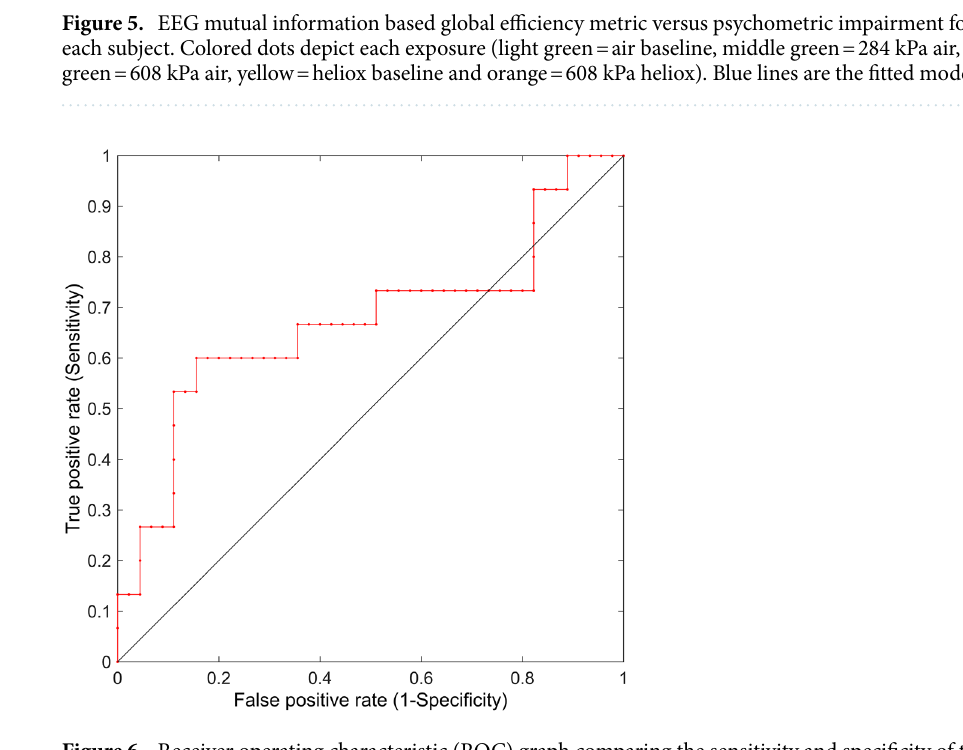
Figure 6. Receiver operating characteristic (ROC) graph comparing the sensitivity and specificity of the EEG mutual information based global efficiency metric versus the psychometric test